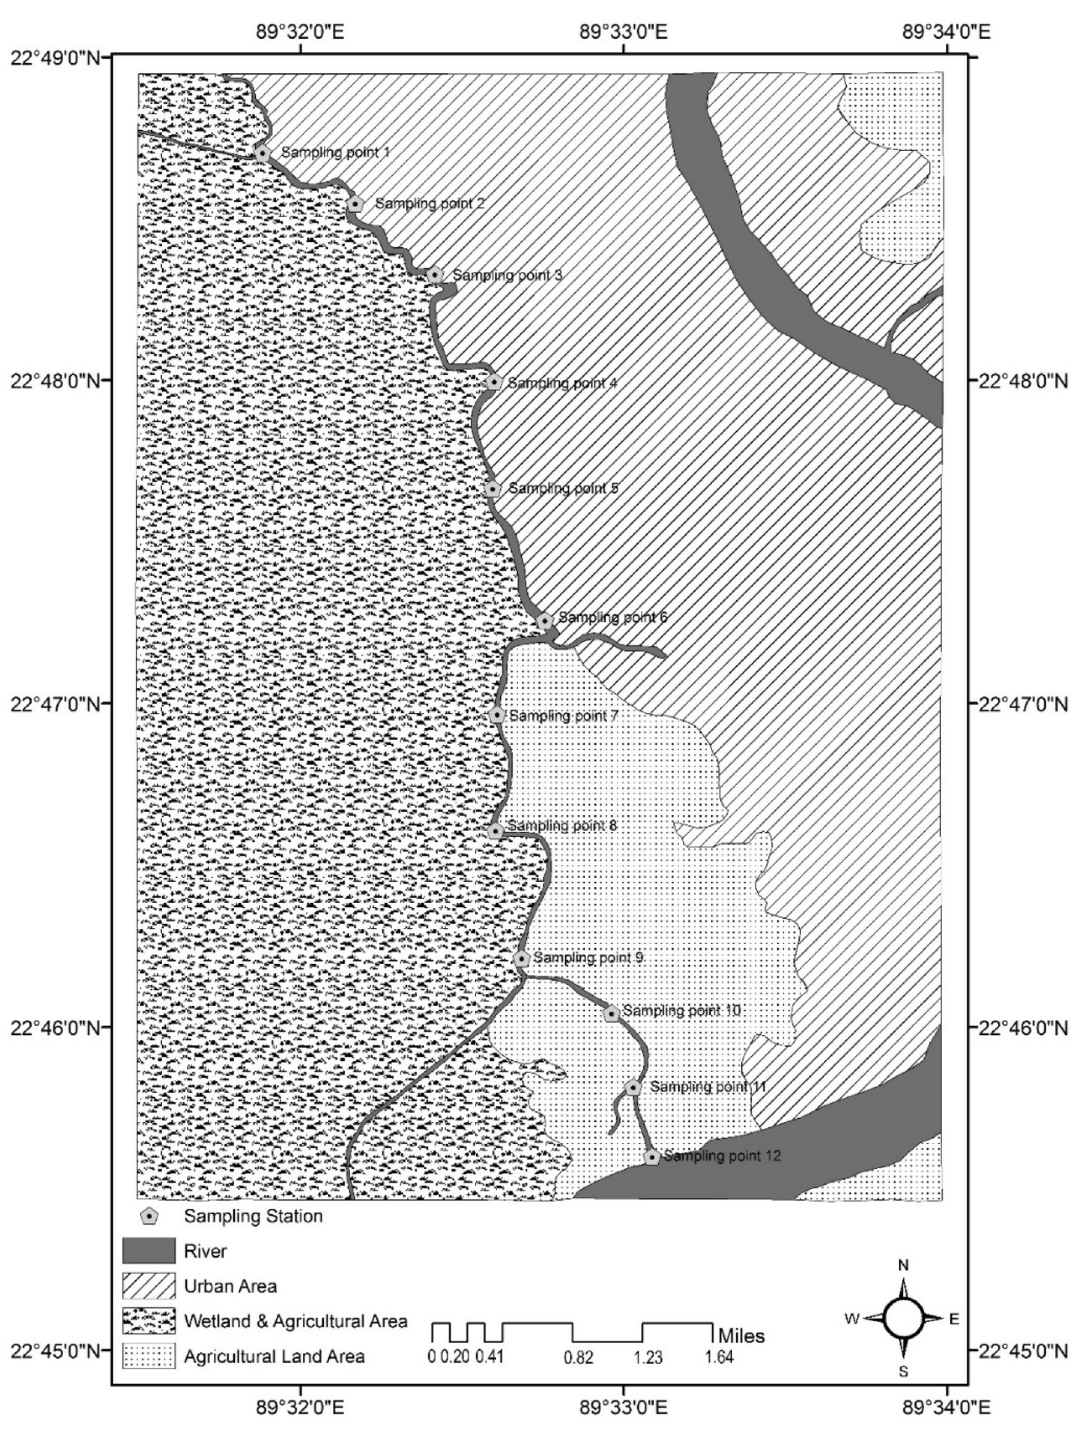
Fig. 1 Distribution of sampling points and major land use pattern in the Mayur River